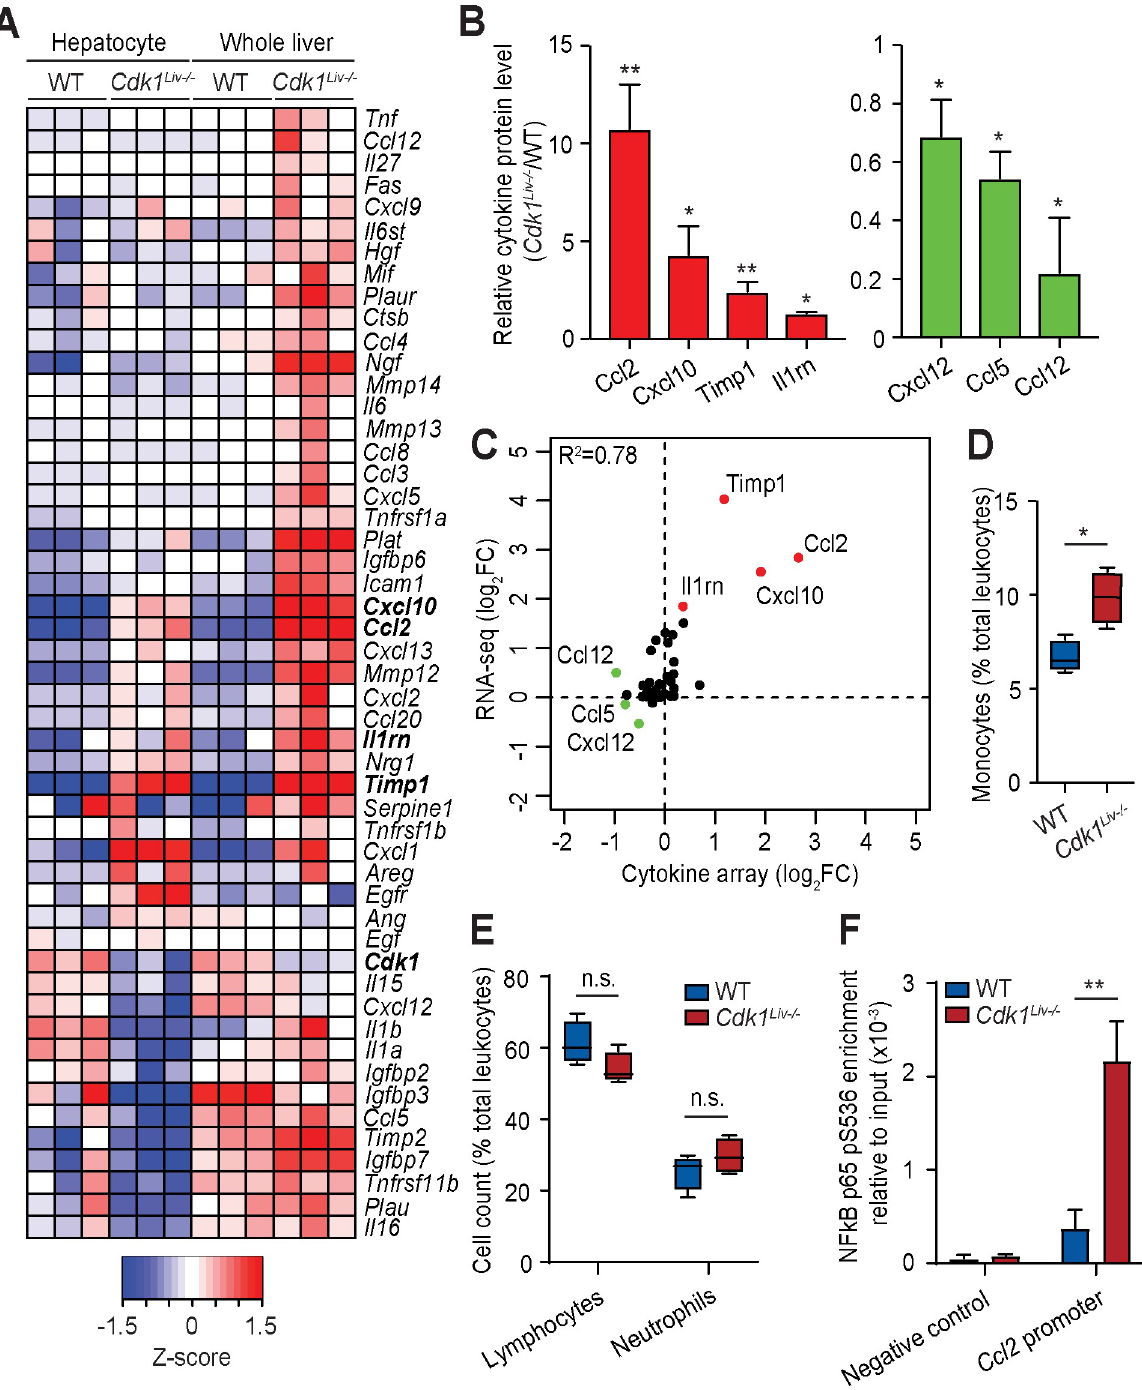
Fig 5. Characterization of the inflammatory response in Cdk1 Liv-/- liver. (A) Heat map of inflammation-associated genes from the RNAseq analysis. Color scale represents Z-score. (B) Cytokine array of lysates from P14 whole liver (n = 3 per genotype). (C) Correlation plot of cytokine levels from the RNAseq analysis and the cytokine array. Whole blood from wild type (WT) and Cdk1 Liv-/- mice were analyzed for (D) monocytes, (E) lymphocytes and neutrophils and shown as a percentage (%) of the total number of leukocytes analyzed from the same mouse (n = 4 per genotype). (F) ChIP for NF κ B p65 pS536 from lysates of isolated hepatocytes, probing for the Ccl2 promoter by qPCR (n = 3 per genotype). Error bars represent S.E.M.